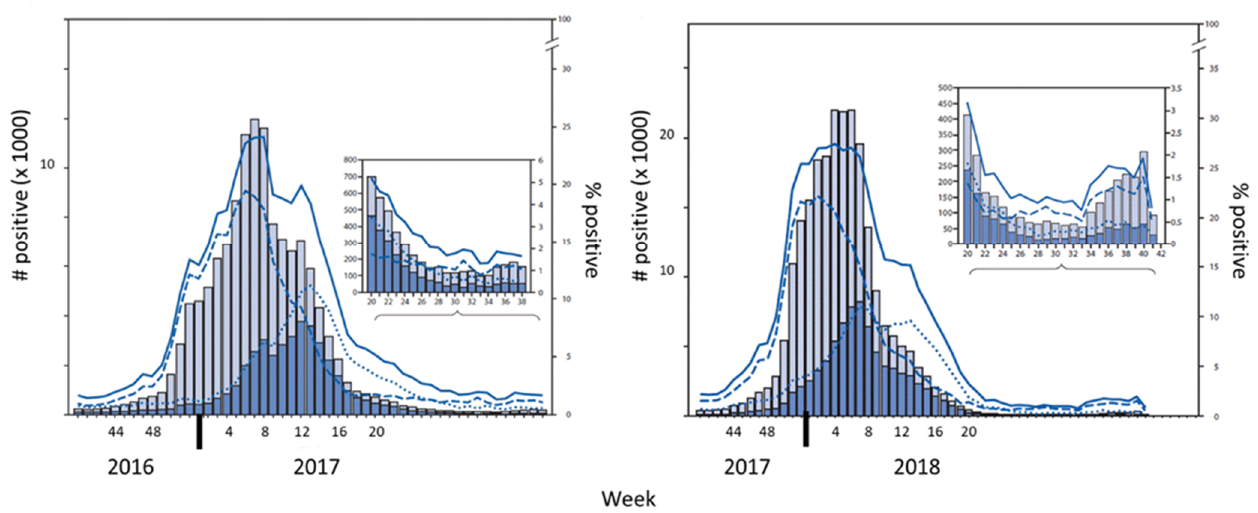
Figure 4. Virus infections during 2016–2017 and 2017–2018 influenza virus seasons. Results are adapted from Centers for Disease Control and Prevention (CDC) reports of influenza virus cases during the 2016–2017 influenza virus season ( left ) [5] and the 2017–2018 influenza virus season ( right ) [6]. Weeks of the year are shown on X axes. Grey bars: numbers of positives for influenza A, blue bars: numbers of positives for influenza B (left Y -axes), Solid line: % respiratory samples testing positive, Dashed line: % positive for influenza A, Dotted line: % positive for influenza B (right Y -axes).